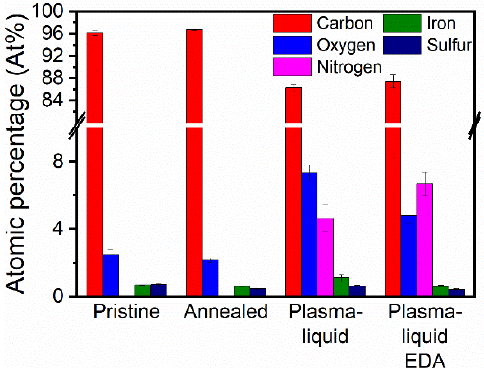
Figure 3. X-ray photoelectron spectroscopy summary of atomic percentages by element for oxygen and nitrogen. The remaining percentage is composed of carbon.